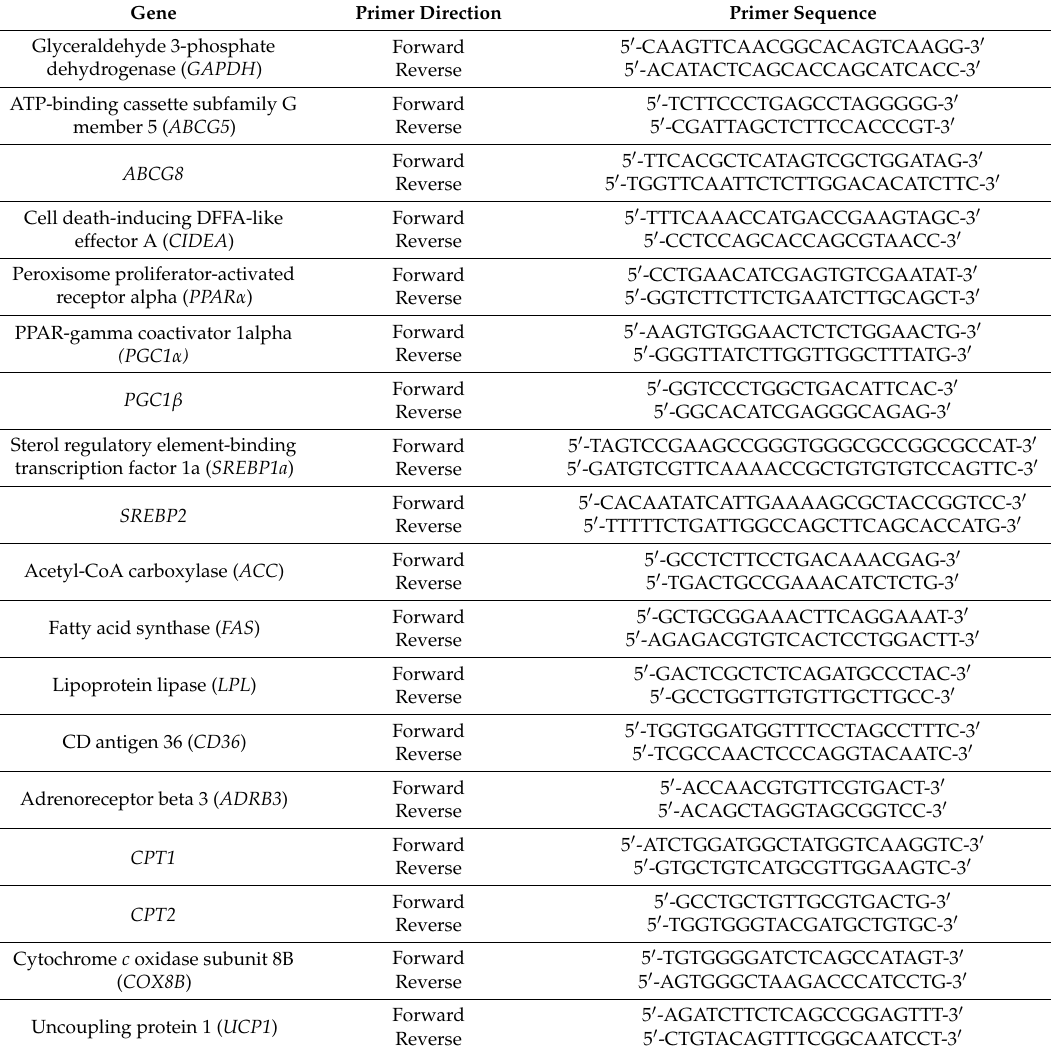
Table 1. Primer sequences used for